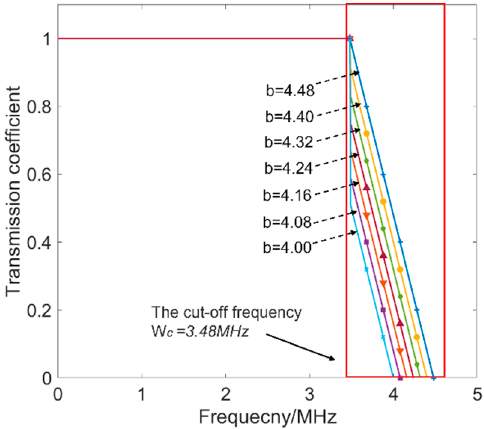
Figure 2. The transmitted coefficients in the frequency band.